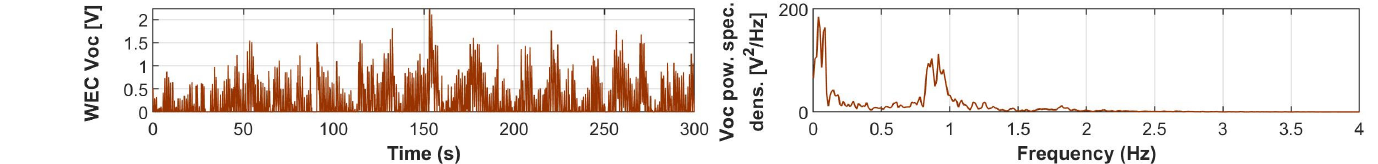
Figure 10. Experimental results of the fi rst test at the sea. Left : time series of the WEC’s open circuit output voltage ( V OC ) in V. Right , power spectral density of V OC .